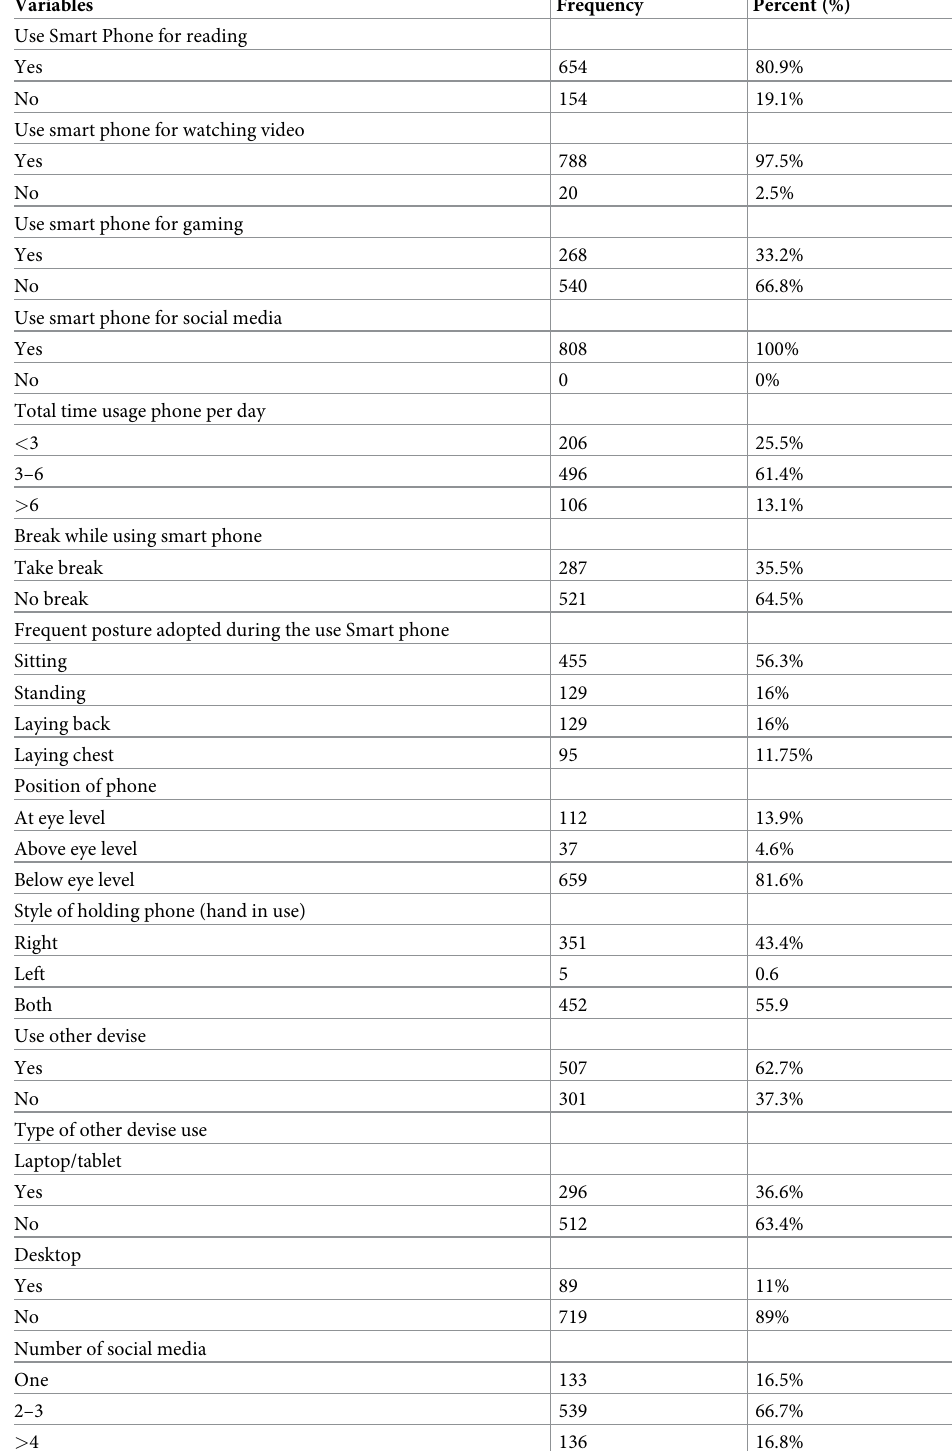
Table 2. Patterns of device use and postural characteristic of smart phone users at University of Gondar, 2020. (N =